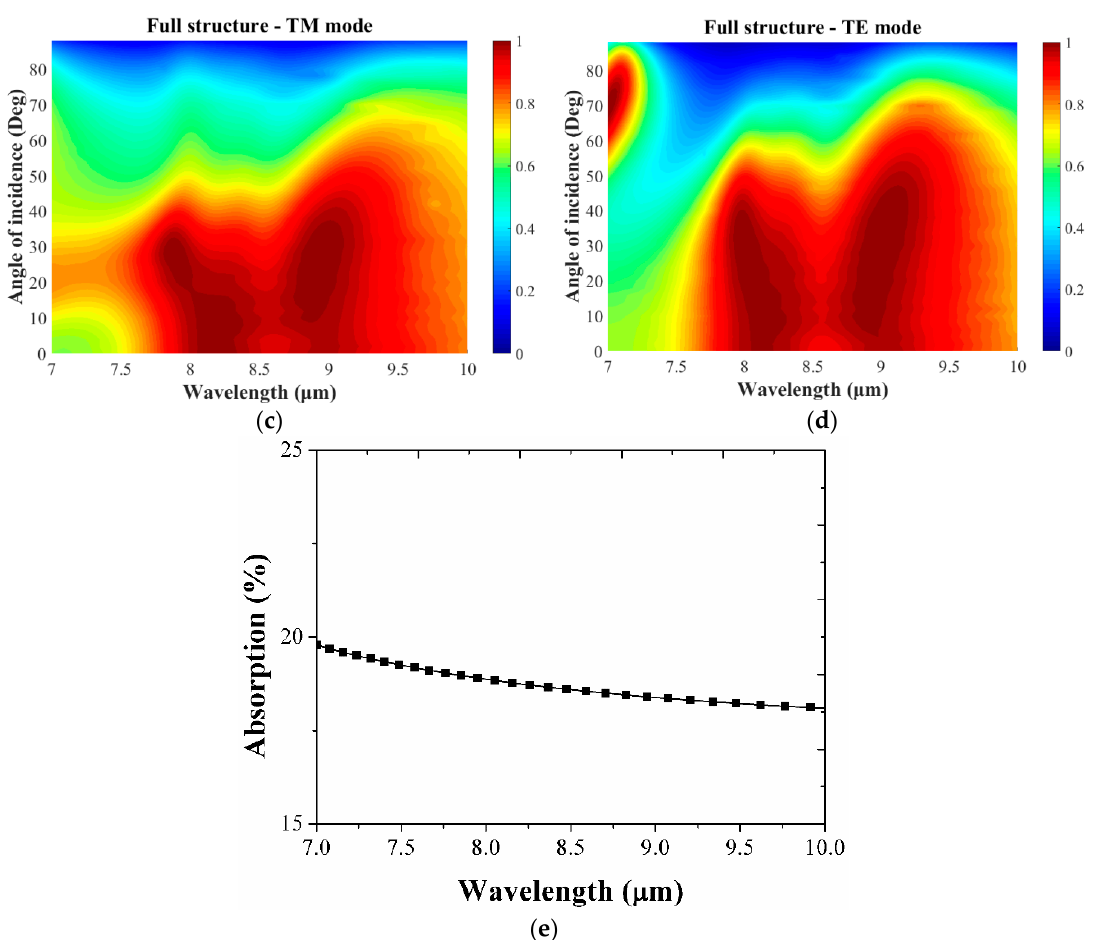
Figure 3. Simulated characteristics of the absorber structures for different incident angles. ( a , c ) transverse-magnetic (TM) mode; and ( b , d ) transverse-electric (TE) mode; and ( e ) the percentage of absorption only in the metal as a function of wavelength.